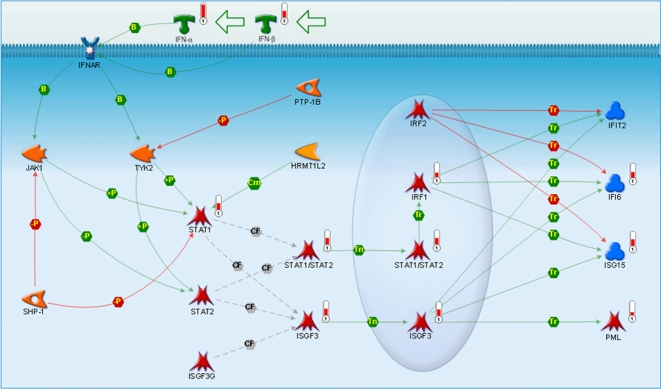
Type I IFN signaling pathway activated in lesional skin of psoriatic patients.Pathway image was generated with GeneGo's MetaCore integrated software suite. Individual symbols within the image represent well–characterized proteins or protein complexes. Arrows linking the proteins represent the stimulatory, inhibitory, or interactive effect of the protein on the target protein. Thermometers adjacent to the individual symbols represent relative expression levels (red indicates overexpression; blue indicates underexpression) of transcripts that encode the protein (or protein complex) within the particular pathway.